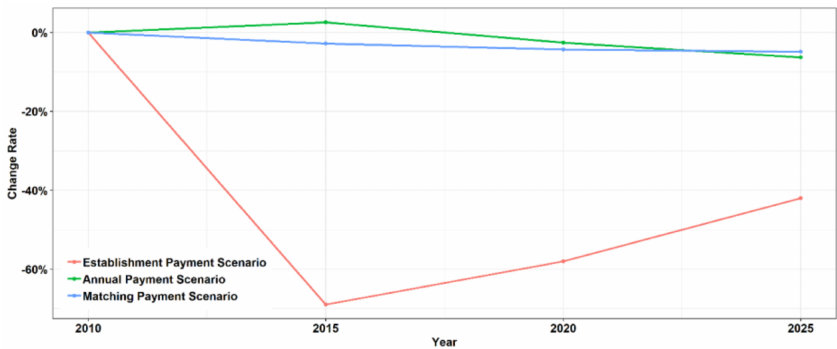
Figure 5. Price change of industrial roundwood.